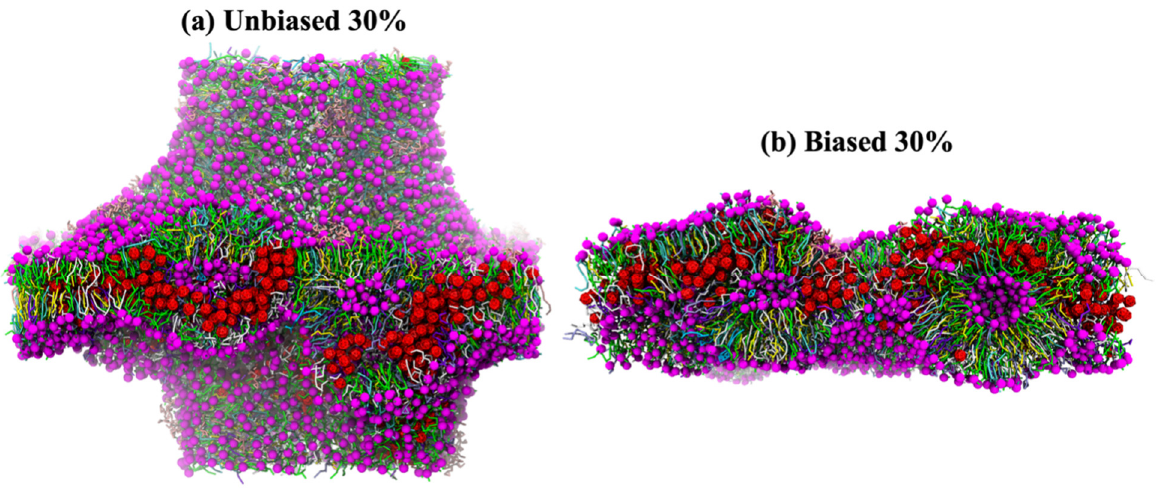
Figure 7. Plasma membrane damage. Side view of ( a ) unbiased and ( b ) biased simulations at fullerene concentration of 30%. Fullerenes are shown in red, cholesterol is colored yellow, and lipid headgroups are colored by type (PC: green, PE: white, SM: cyan, GM: pink, PS: violet, PIPs: aqua, other: ice blue).